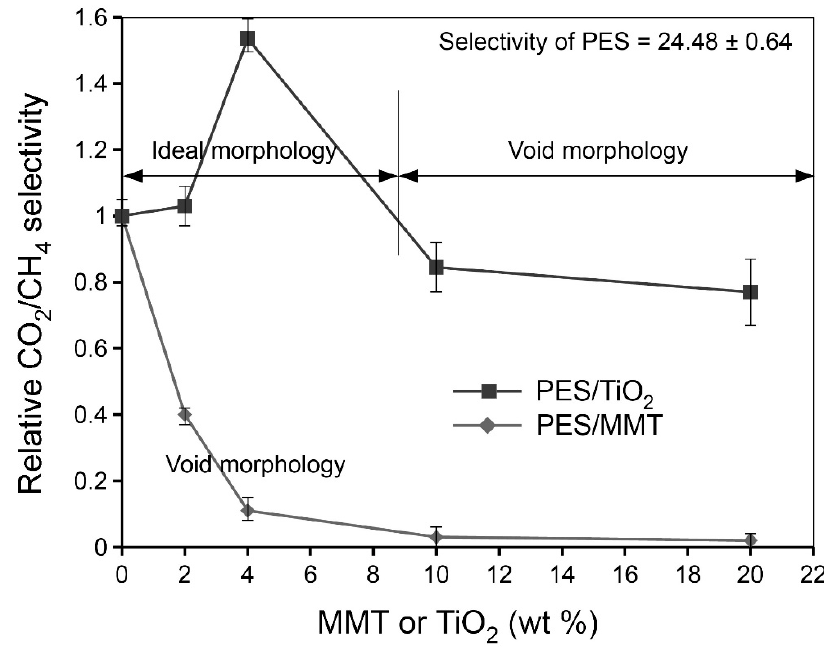
Figure 13. Performance of MMMs compared to the Robeson upper bounds [124].